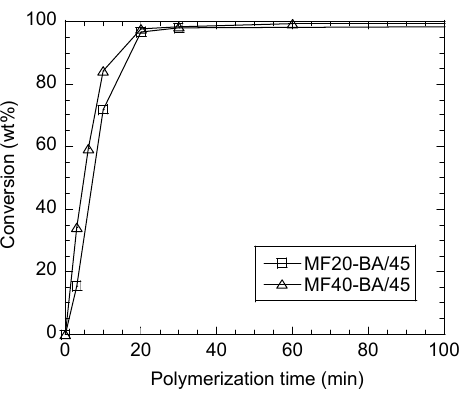
Figure 8. The evolution of overall conversion for the copolymerization of MF with BA at different ratios and 45% solids content.